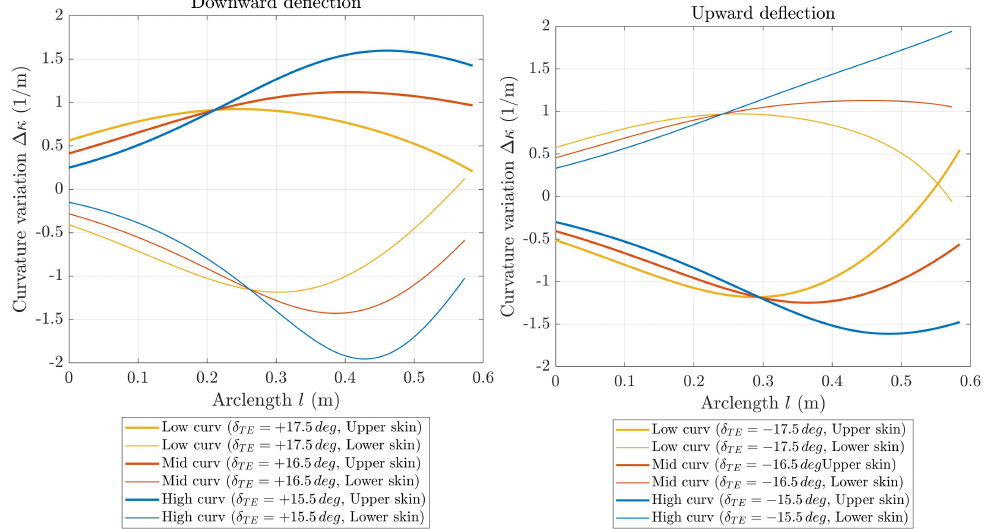
Figure 16. Comparison between curvature-difference distributions of the morphing skin for down- ward and upward deflections.